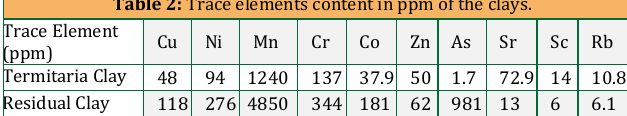
Table 2: Trace elements content in ppm of the clays.